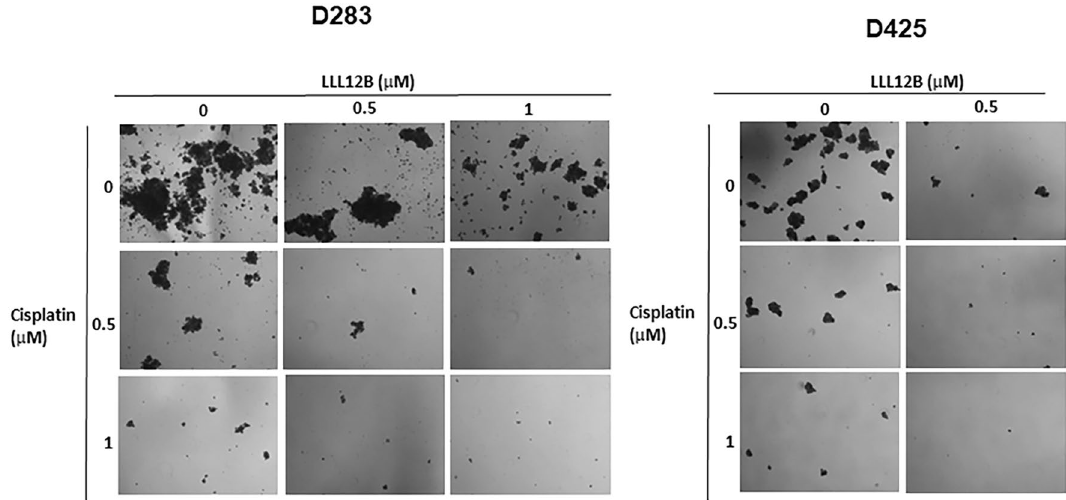
Figure 8. Inhibitory effect of tumorsphere formation after combination treatment with LLL12B and cisplatin. Cells were plated in ultra-low attachment 6-wells at 10,000 cells/mL and treated with LLL12B (0.5 and 1 μM) and/or cisplatin (0.5 and 1 μM) for 8 days. Images were captured on a Nikon Eclipse TS100 microscope. Original magnification, × 10.